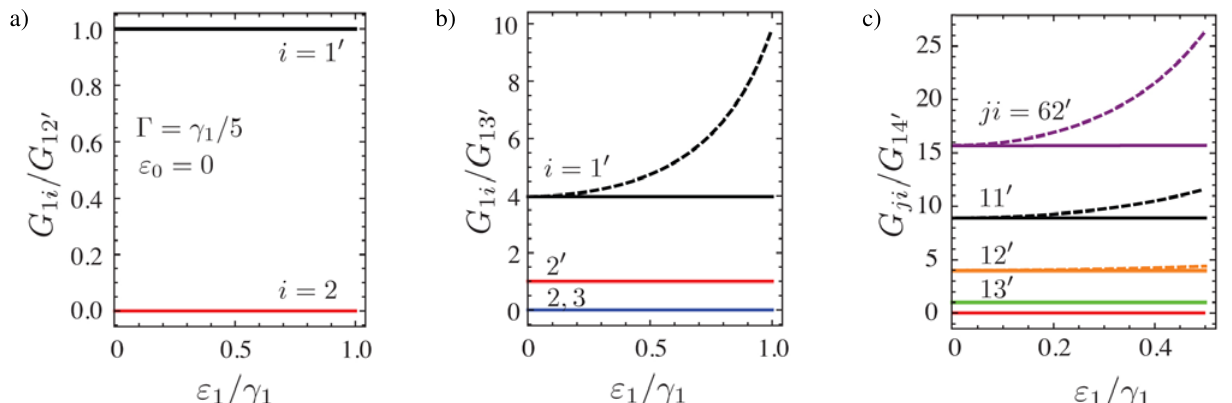
at molecular sites 1 = 0. He- 1